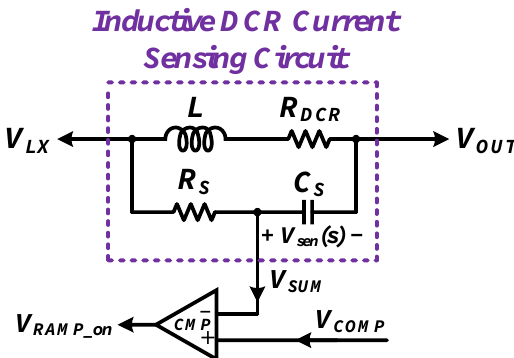
Figure 8. Schematic of the inductive DC resistance (DCR) current sensing circuit.